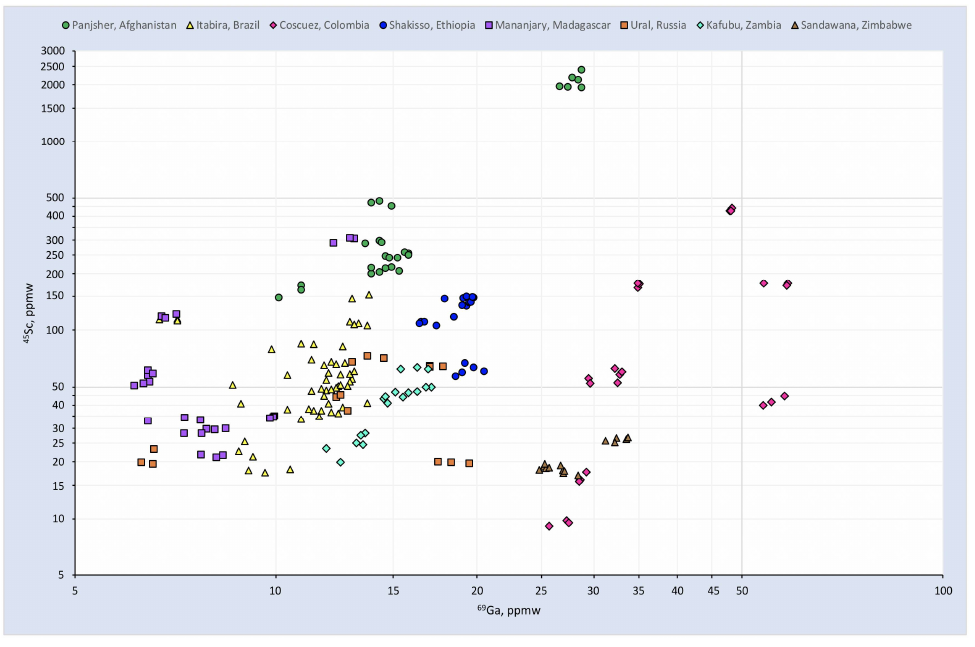
Figure 9. Binary plot of 69 Ga vs. 45 Sc.